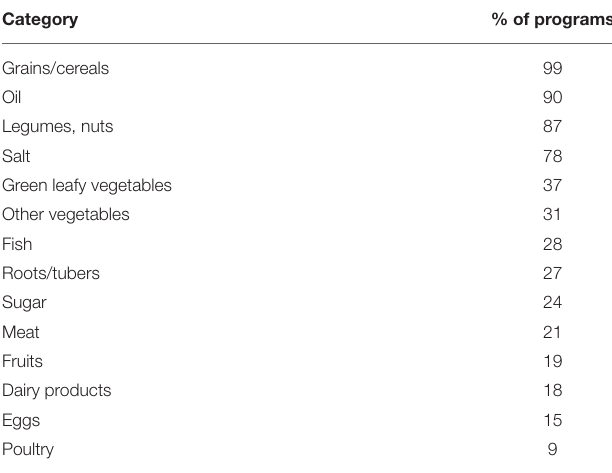
TABLE 2 | Food items served in school meal